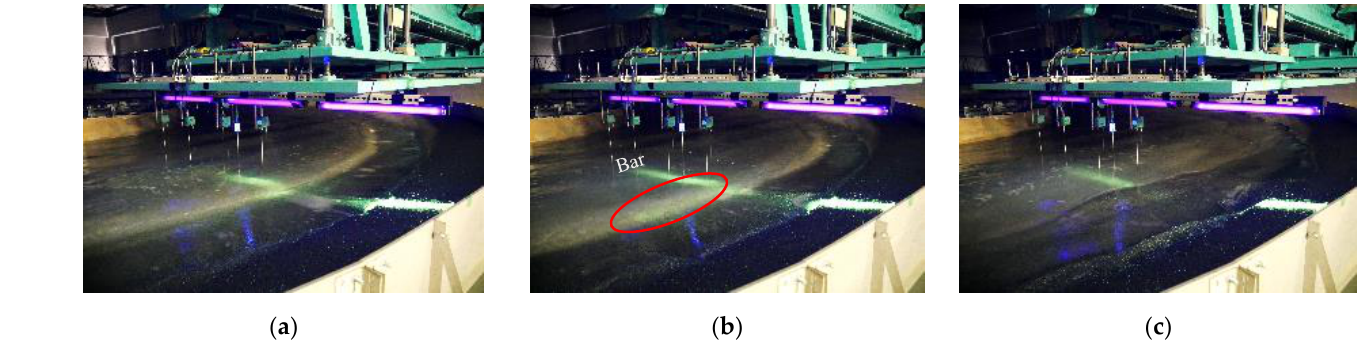
Figure 12. Snapshots of fluorescent sands movement during the experiment in Case 4: ( a ) after 1 min ( b ) after 5 min ( c ) after 60 min.